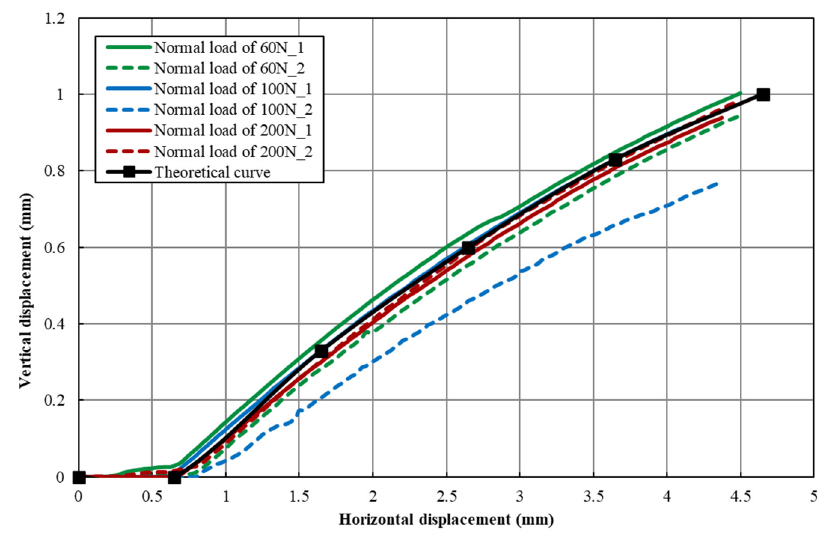
Figure 8. Comparison between measured and calculated vertical displacements based on the meas- ured interparticle friction angle under the normal load of 60 N.